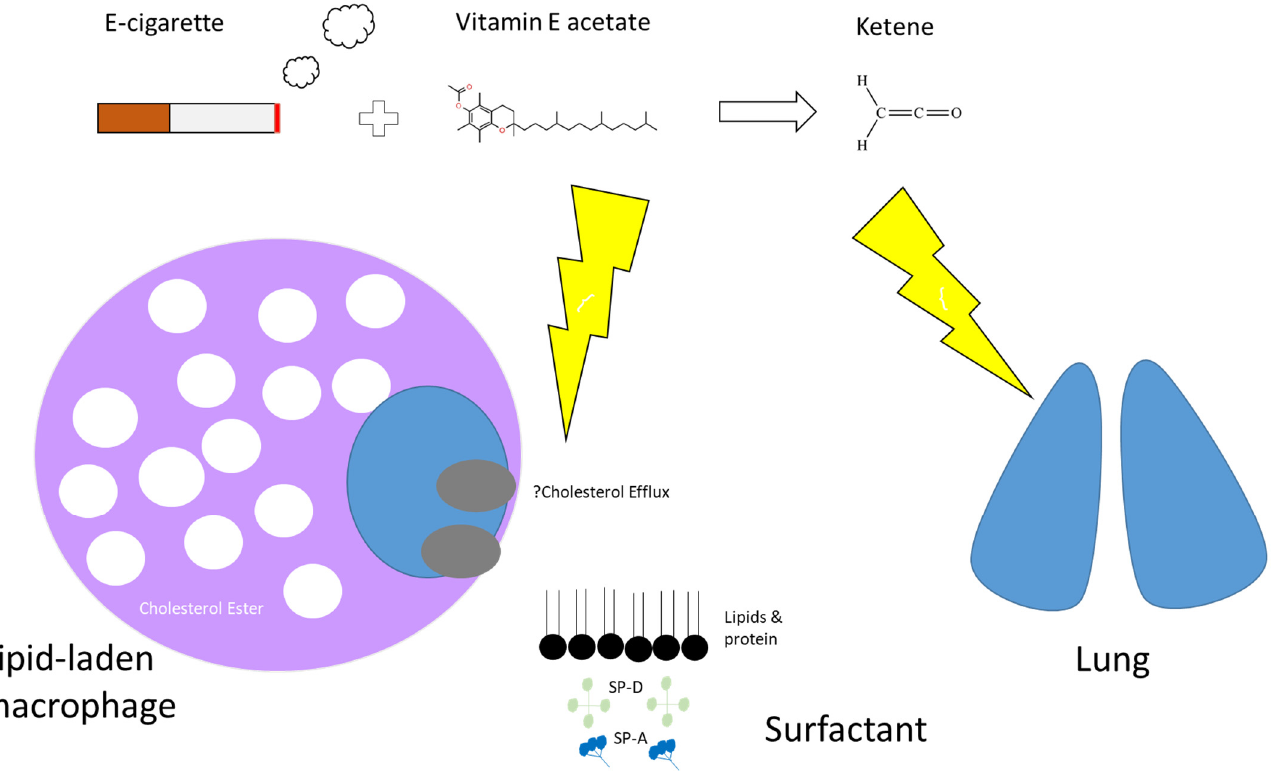
Figure 4. Proposed mechanism of action by which e-cigarettes cause lung injury. Many e-cigarettes that contain tetrahydrocannabinol (THC) have been shown to have higher levels of vitamin E acetate, commonly used as a thickening agent. It is possible that increased exposure of the lungs to Vitamin E (naturally occurring at low levels in surfactant) or Vitamin E acetate could affect the physical structure and phase behaviour of surfactant, impairing its ability to maintain surface tension leading to respiratory distress. Dysfunctional surfactant might lead to excess lipid accumulation within alveolar macrophages and that reverse cholesterol transport or cholesterol efflux might be implicated. Secondly, a known product of vaporised vitamin E acetate is ketene which is believed to be a lung irritant.